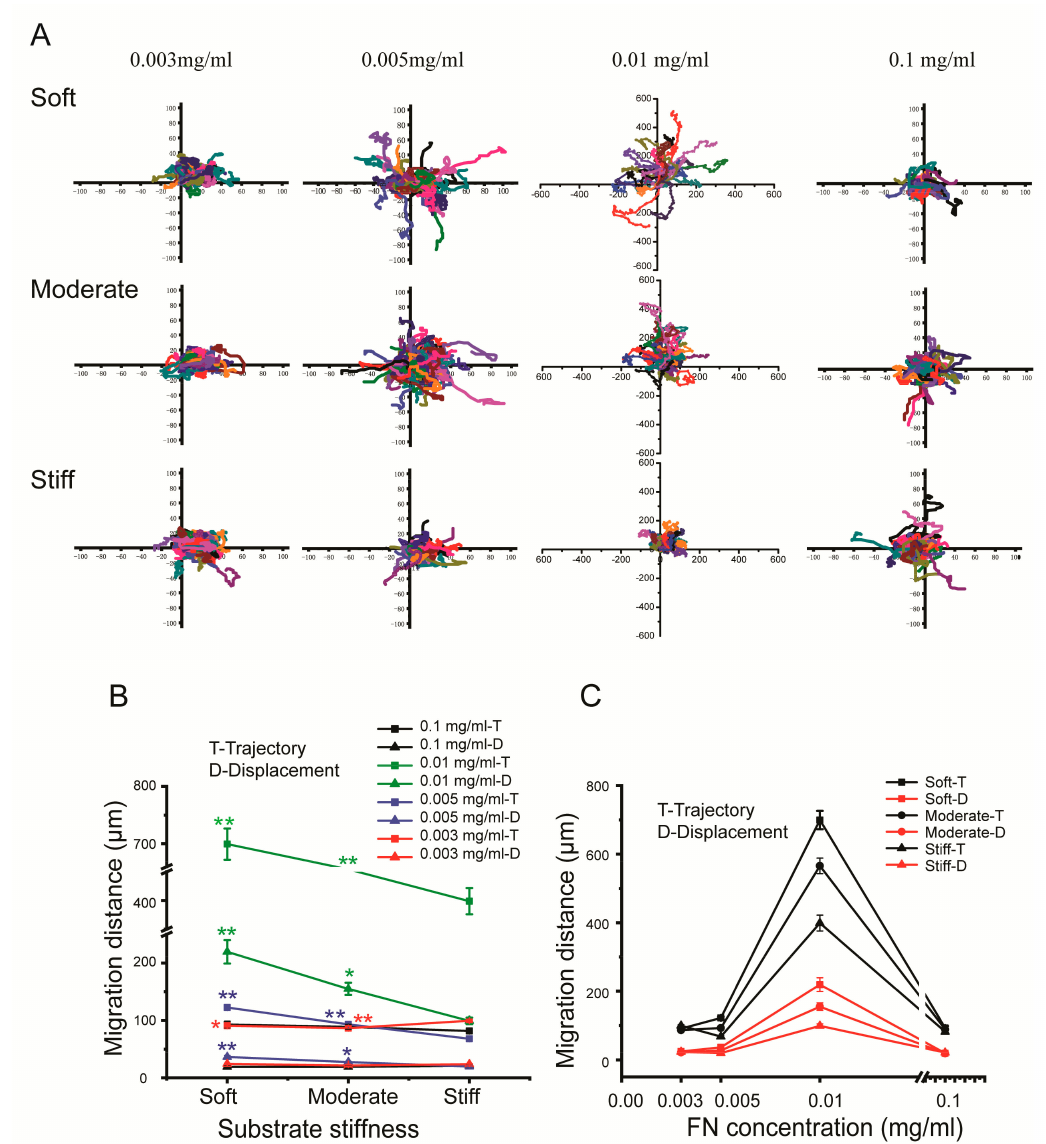
Figure 2. Cellular migration trajectory of hepatocytes cultured on substrates of di ff erent sti ff ness and di ff erent concentrations of fibronectin. ( A ) Cellular migration trajectory of hepatocytes cultured on substrates of di ff erent sti ff ness and varying concentrations of fibronectin, ( n ≥ 30). Cellular migration trajectory and displacement are plotted based on increasing substrate sti ff ness ( B ) and fibronectin concentration ( C ). Soft and moderate groups compared to the sti ff group. Data were presented as the mean ± SEM ( n ≥ 30). * represents p < 0.05; ** represents p <